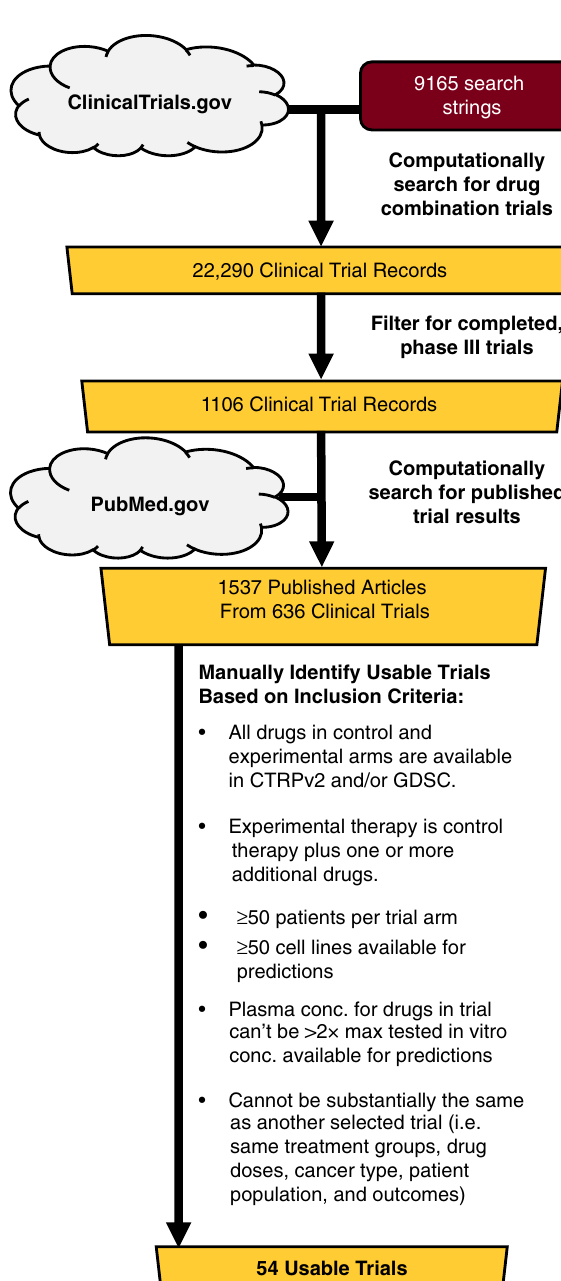
Fig. 3 Trial selection pipeline for clinical validation. Flowchart detailing how completed, phase III cancer clinical trials were selected for the clinical trial validation analysis. Searches of ClinicalTrials.gov and PubMed.gov were performed via web scraping (see “ Methods ” section) to identify published results for trials that may meet our inclusion criteria, and